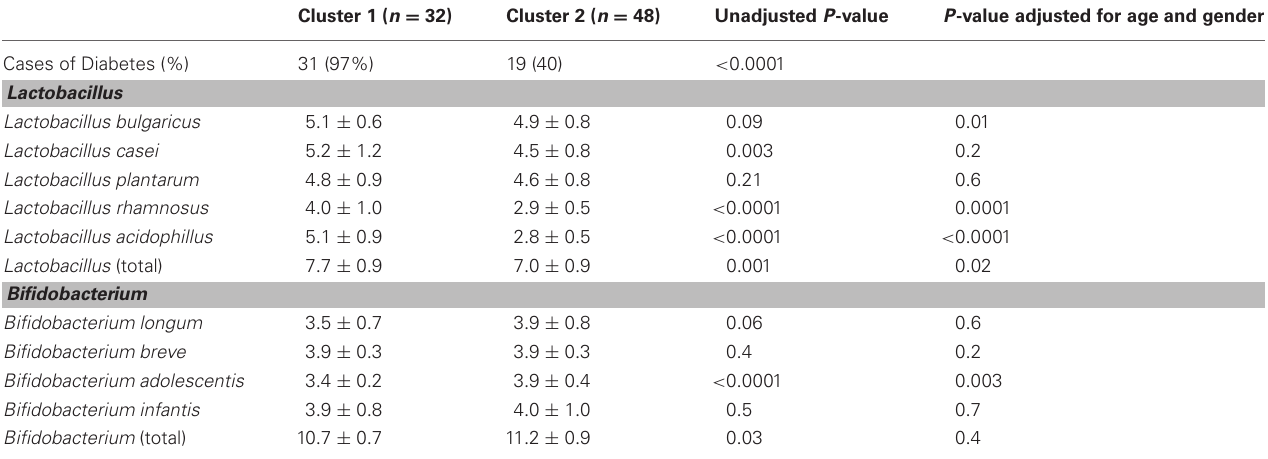
Table 4 | Comparisons of bacteria amount by clusters (bacterial values transformed using logarithm). Cluster 1 ( n = 32) Cluster 2 ( n =